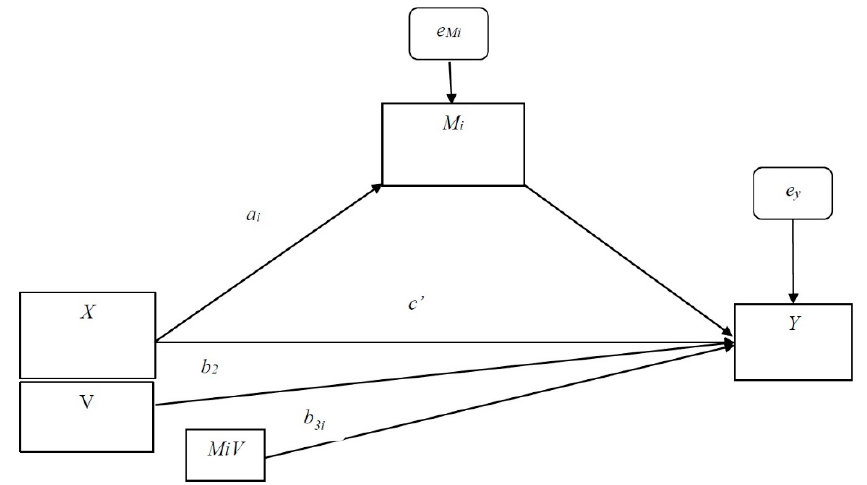
Figure 2. Statistical model for the Study (Model 14 PROCESS). Conditional indirect effect of X on Y through M i = a i ( b 1i + b 3i V ).